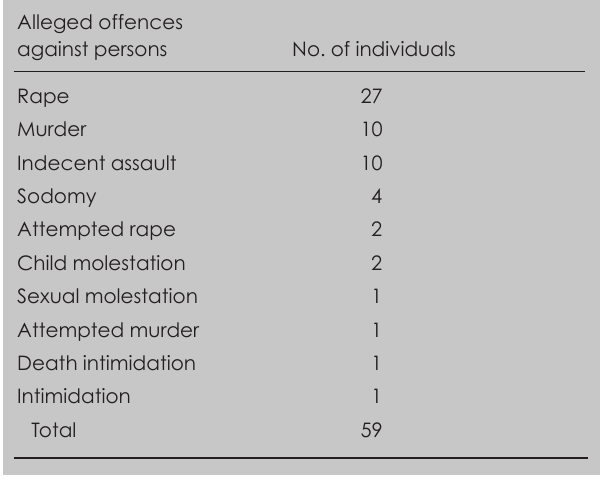
Table III. Alleged offences against persons